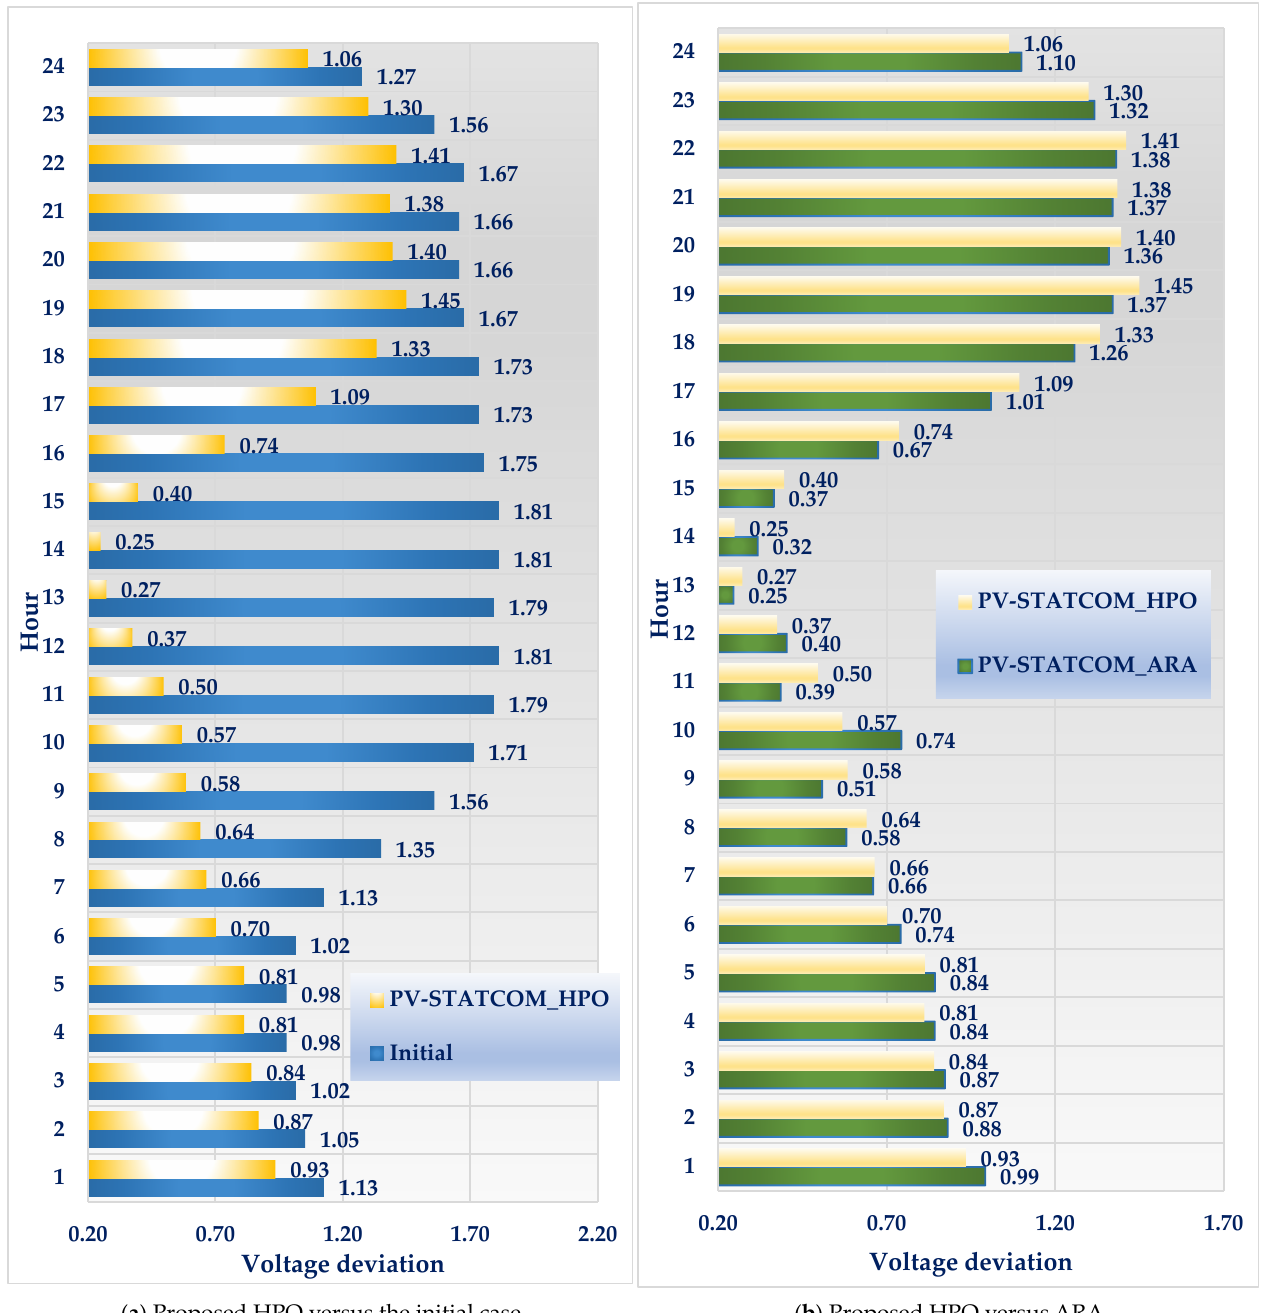
Figure 7. Hourly voltage deviations based on the proposed HPO versus the initial case ( a ) and ARA ( b ) for IEEE 33-distribution feeder.